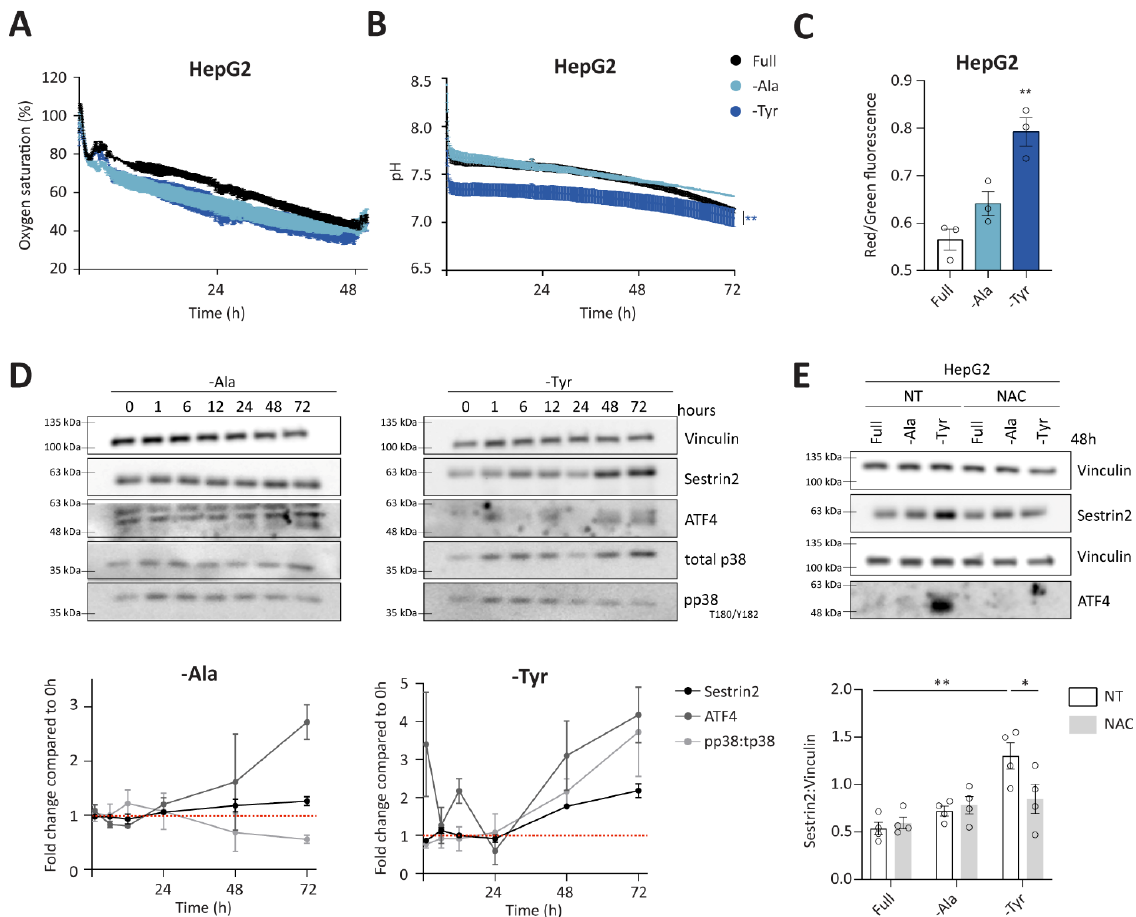
Figure 5. Group 3 of amino acid deprivations causes oxidative stress. ( A , B ) Continuous measure- ments of oxygen saturation ( A ) and pH ( B ) values in extracellular medium. Twoway ANOVA with Dunnett’s post hoc test was used to calculate statistical significance between slopes; ( C ) mitochondrial membrane potential measured 48 h of amino acid deprivations; ( D ) time-dependent regulation of Sestrin2, ATF4, and phosphorylation of p38 upon the deprivations in HepG2 cells, with respective densitometric quantification (n = 3); ( E ) Sestrin2 and ATF4 levels upon 10 mM Nacetyl cysteine cotreatment with densitometric quantification (n = 3). Twoway ANOVA with Tukey’s post hoc test was used to calculate statistical significance. Dots represent individual values. * and ** indicate p ≤ 0.05 and 0.01, respectively.